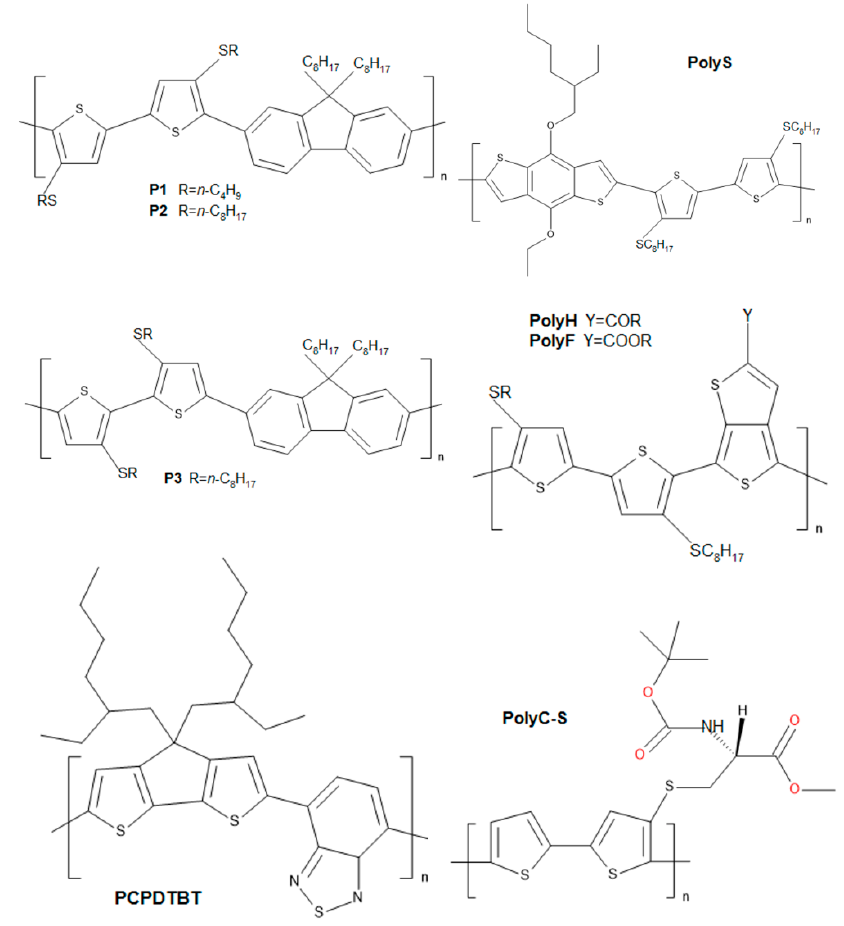
Figure 1. Polymer structures studied in this work.